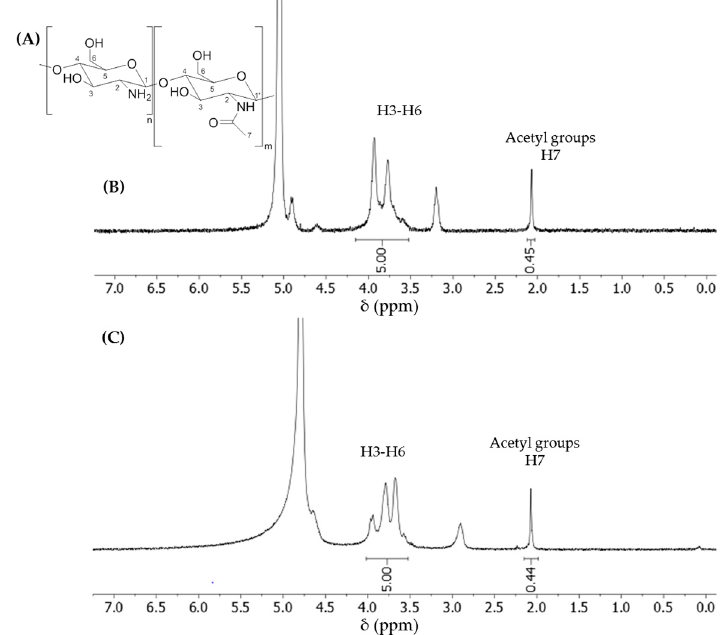
Figure 1. ( A ) Chemical structure of the partially acetylated chitosan. The typical 1 H nuclear magnetic resonance (NMR) spectrum of ( B ) dCS-A in D 2 O + 1% DCl and ( C ) dCS-A in D 2 O, obtained by microwave-assisted depolymerization (Table 1, Entry 6). Table 2. Progressive dissolution of CS-A, CS-B and dCS-A in aqueous acidic solution. Entry Sample Starting pH a Final pH